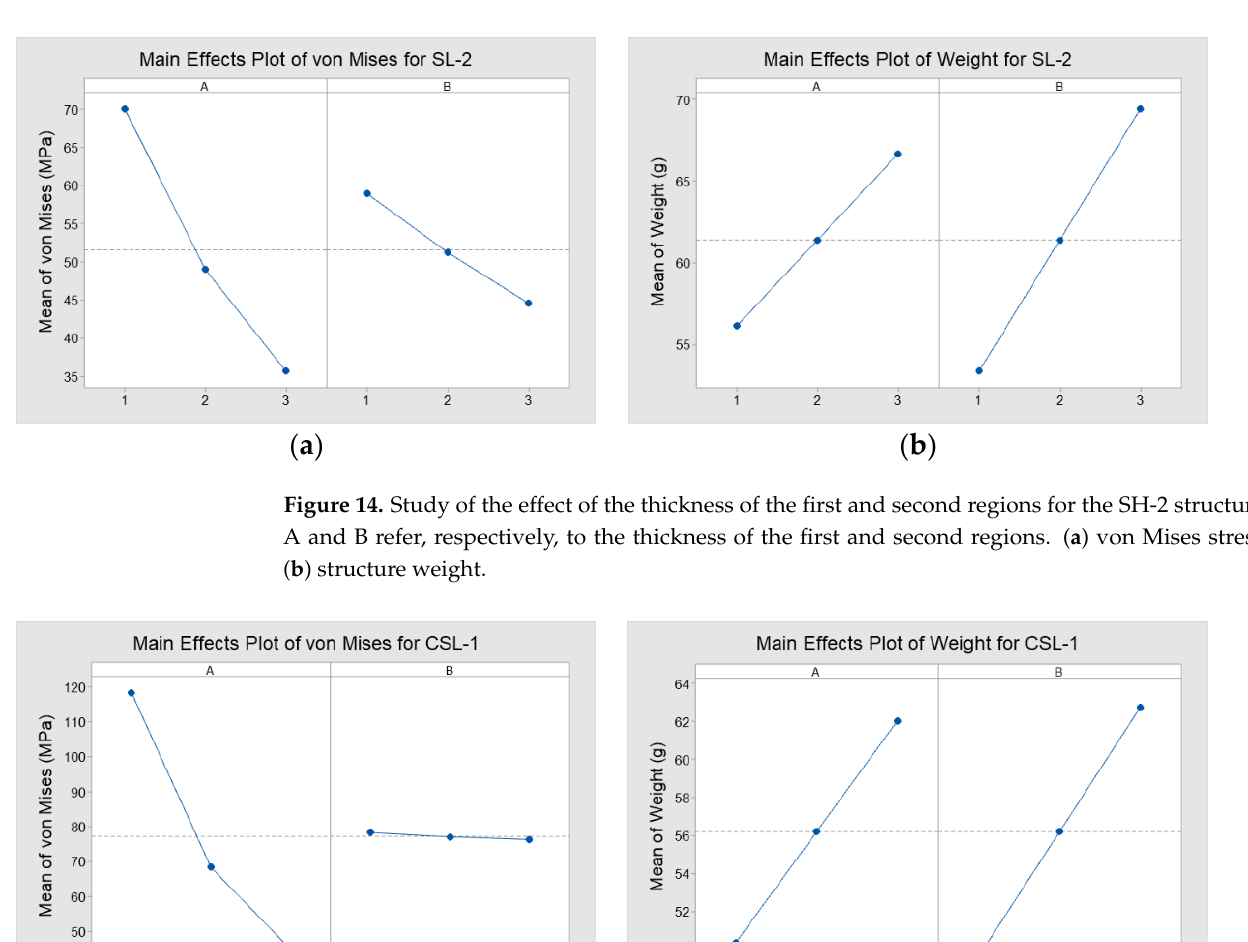
structure weight. ( b )